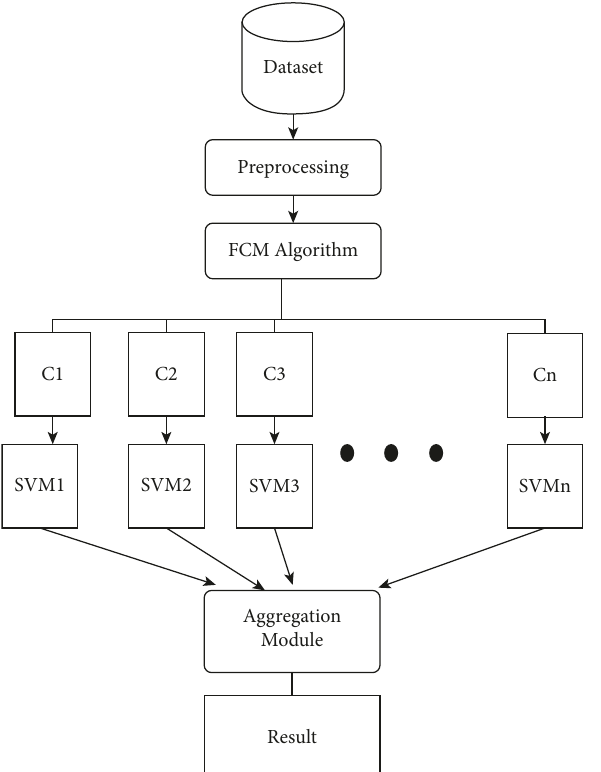
Figure 5: Flowchart of FCM-SVM methodology.